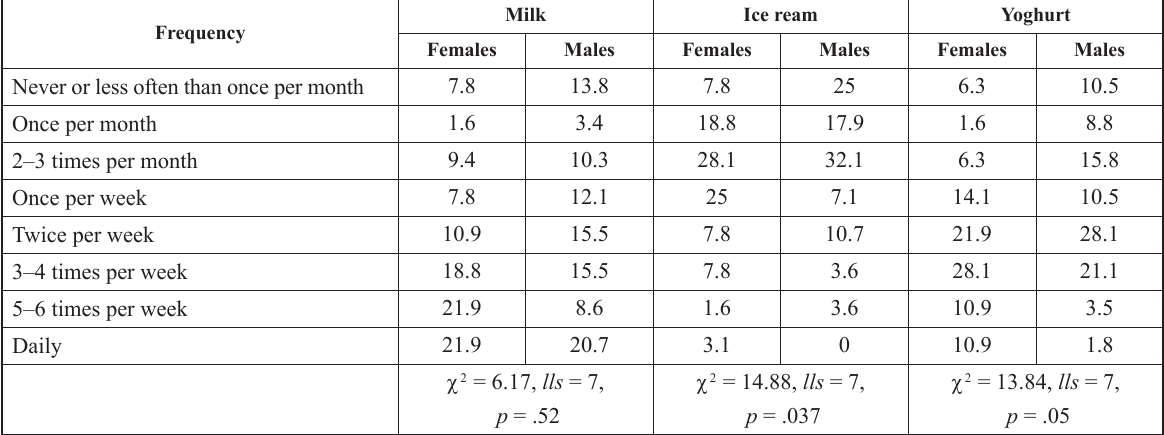
Table 2. Frequency of milk, ice cream and yoghurt consumption according to gender (%)